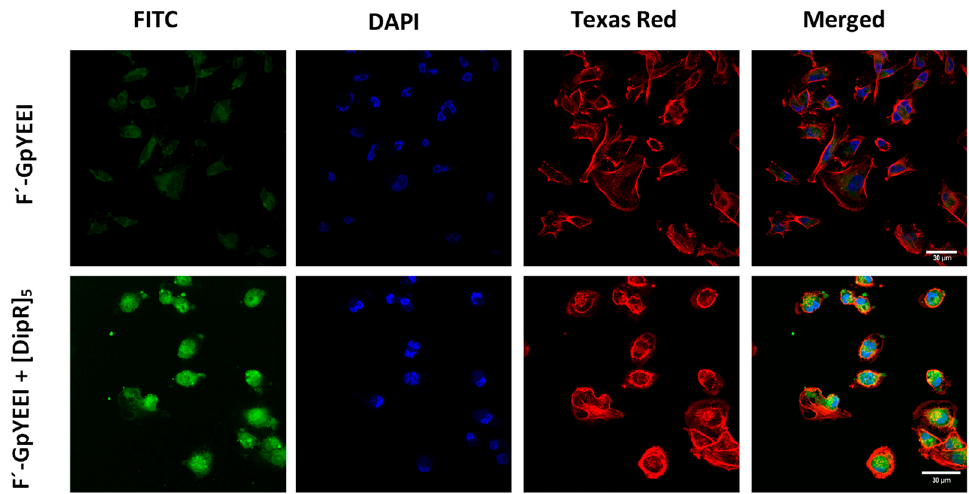
Figure 13. The confocal microscopy images of F’-GpYEEI (2 µM) in the presence of [DipR] 5 (10 µM) after incubation for 3 h with MDA-MB-231 cells. Videos of the images are available in supplemen- tary materials.